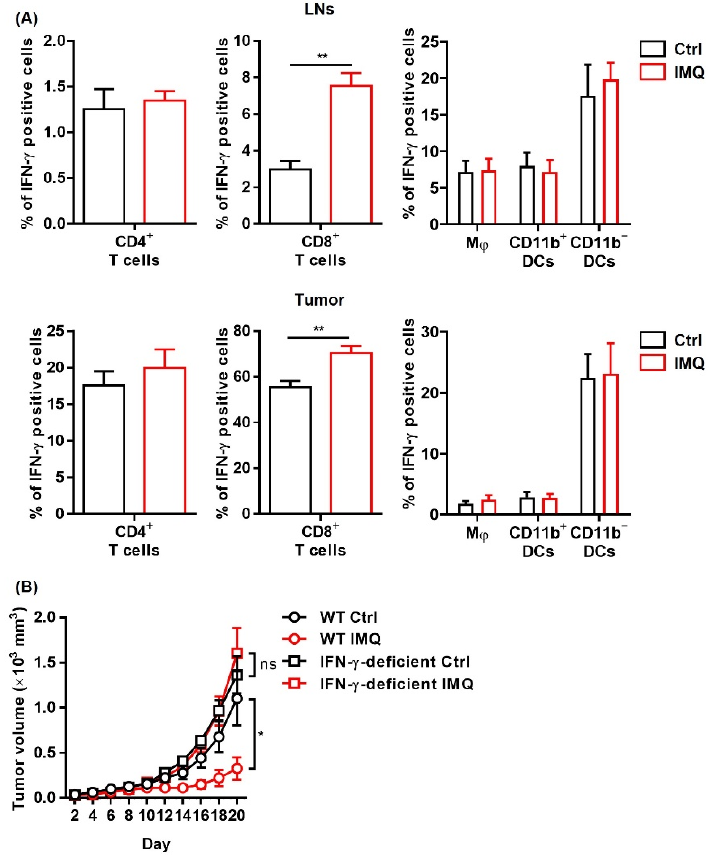
Figure 4. The IMQ-induced antitumor effect is dependent on IFN- γ . ( A , B ) Flow cytometric analysis of IFN- γ expression in CD4 + T cells, CD8 + T cells, M ϕ , CD11b + DC, and CD11b − DC in the lymph nodes ( A ) and tumors ( B ) 8 days after tumor inoculation with IMQ application at day 7 ( n = 5 in each group). ( C ) Time course of the tumor volume after 2 × 10 6 MC38 colon cancer cells were intradermally inoculated into the backs of wildtype or IFN- γ -deficient mice with topical IMQ application or no treatment ( n = 8 in each group). WT: wildtype, Ctrl: control, IMQ: imiquimod, M ϕ : macrophages, DCs: dendritic cells, LNs: lymph nodes, IFN- γ : interferon γ , ns: not significant. Error bars indicate ±1 SEM; * p < 0.05, ** p < 0.01.